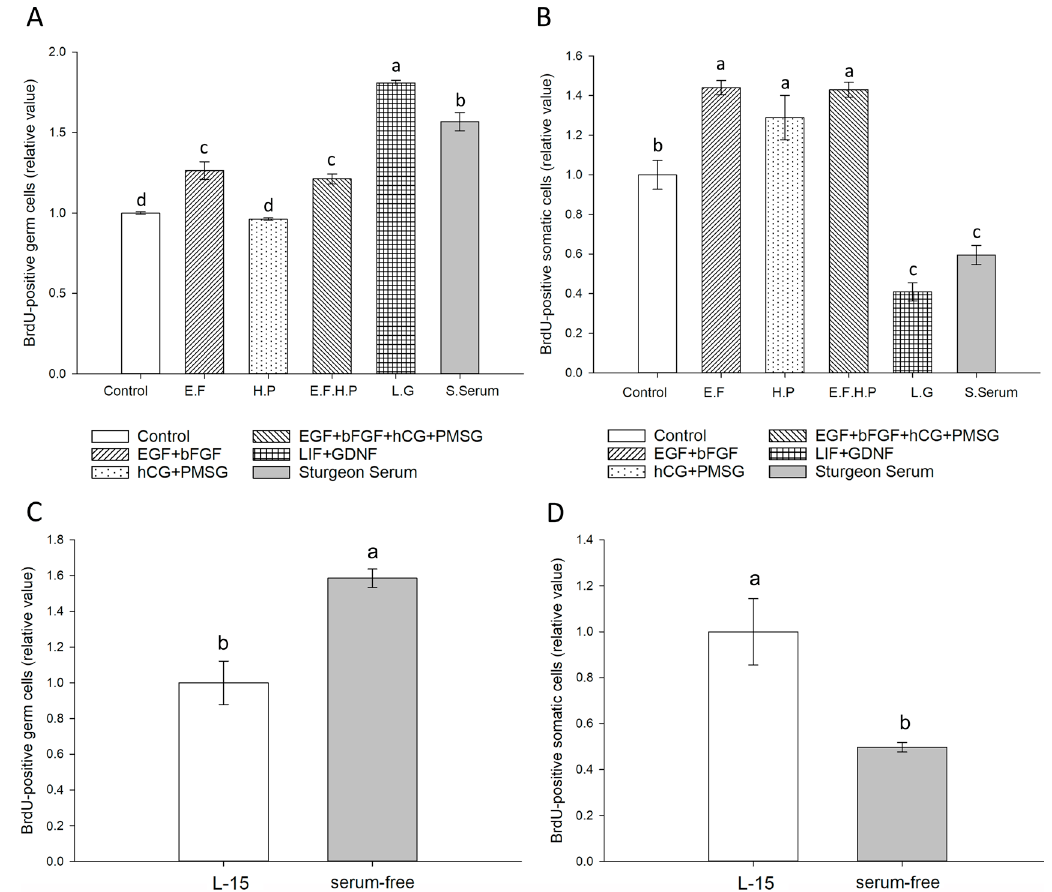
Figure 6. Effects of selected soluble growth factors on mitotic activity of Dabry’s sturgeon germ cells ( A ) and somatic cells ( B ). The number of germ cells was counted on Day 10. The somatic cell mitotic activity after addition of EGF and bFGF (E.F), hCG and PMSG (H.P), EGF/bFGF/hCG and PMSG